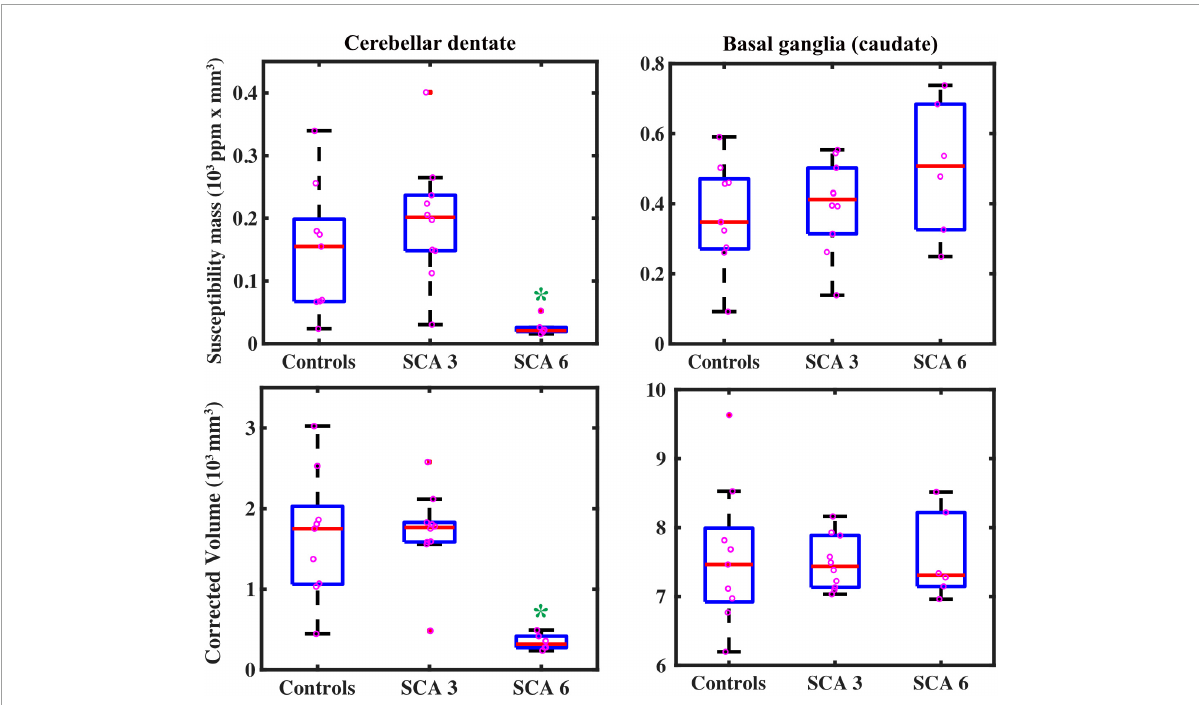
FIGURE3 QSM-derived normalized susceptibility mass (mean magnetic susceptibility × Corrected ROI Volume in the unit of 10 3 ppm × mm 3 ) in the dentate nuclei (top left) showed significant group differences. * = SCA6 < SCA3 ( p < 0.001) and SCA6 < healthy controls ( p = 0.002). Group differences were not significant in the basal ganglia (using caudate as a proxy, top right) SCA6 = SCA3 = healthy controls ( p = 0.26). Volume measures showed similar results: in the dentate (bottom left), * = SCA6 < SCA3 ( p < 0.001) and SCA6 < healthy controls ( p = 0.001); groups did not differ for caudate volume (bottom right), SCA6 = SCA3 = healthy controls ( p = 0.96), but SCA6 = SCA3 < healthy controls in the putamen ( p = 0.046, see Table 3 ). Boxplots represent first (Q1) and third (Q3) quartiles; bars indicate minimum (Q0) and maximum (Q4) values, excluding outliers; red lines represent the